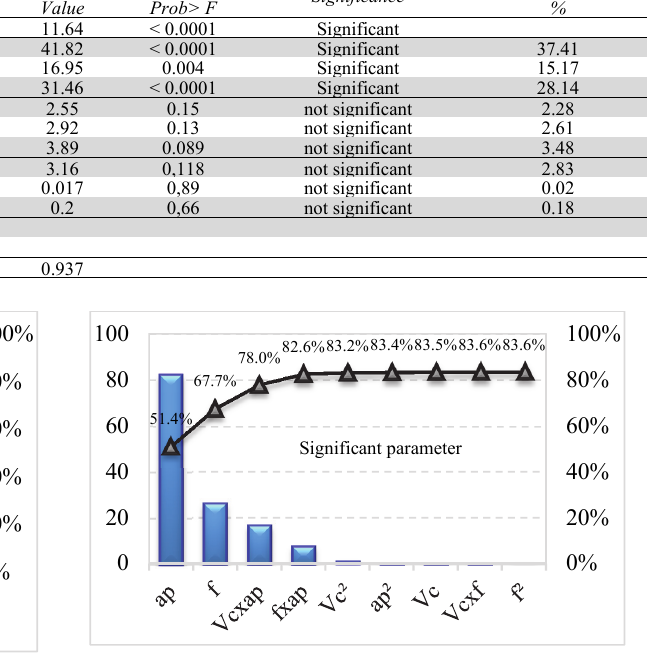
Fig. 4. Pareto chart of the standardized effects on surface roughness Fig. 5. Pareto chart of the standardized effects on cutting force ( α ( α =0,05)